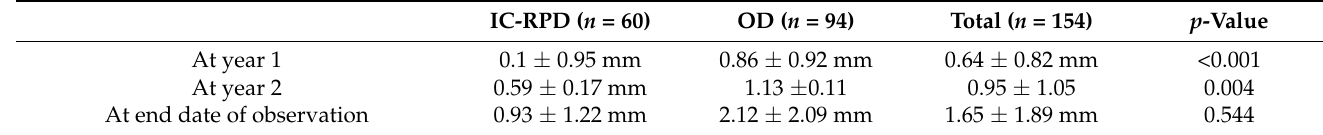
Table 5. MBL of implants in IC-RPDs and IODs at year 1 and at end date of